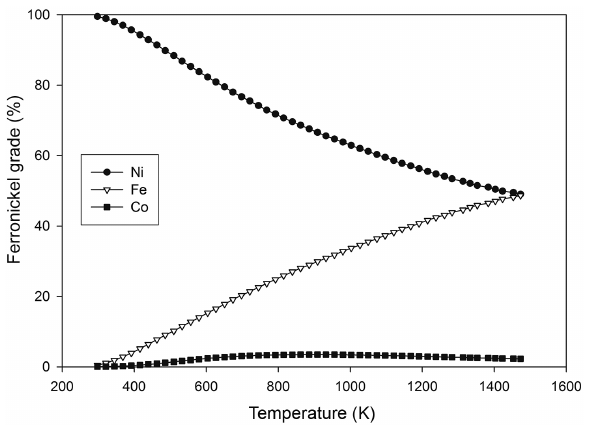
Figure 4: Effect of temperature on the composition of the ferronickel alloy for reduction of the ore in hydrogen at a reductant to ore ratio of 0.558 kmol/100 kg.